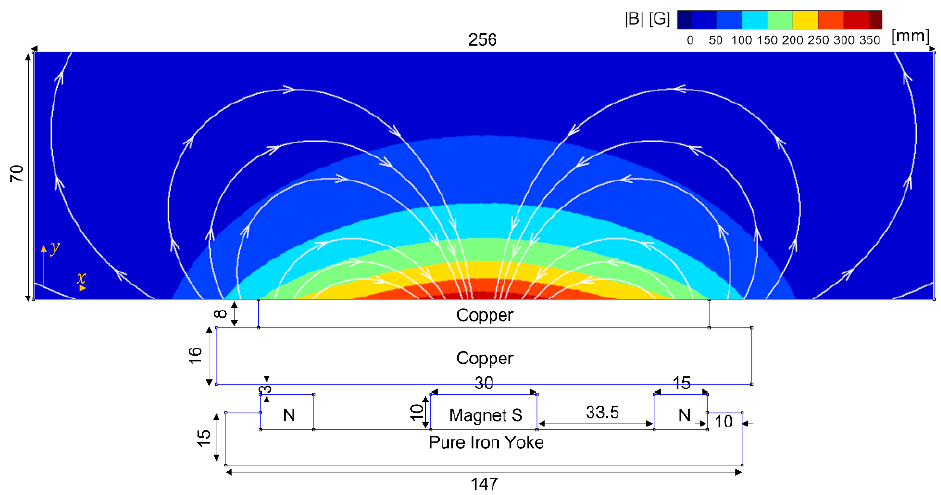
Figure 5. Magnetic field lines and the magnitude of the magnetic flux density of 350 G case with a magnetic yoke with a thickness of 15 mm .